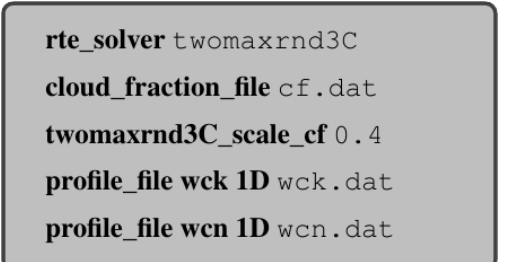
Figure A1. An example of invoking the Tripleclouds solver within libRadtran